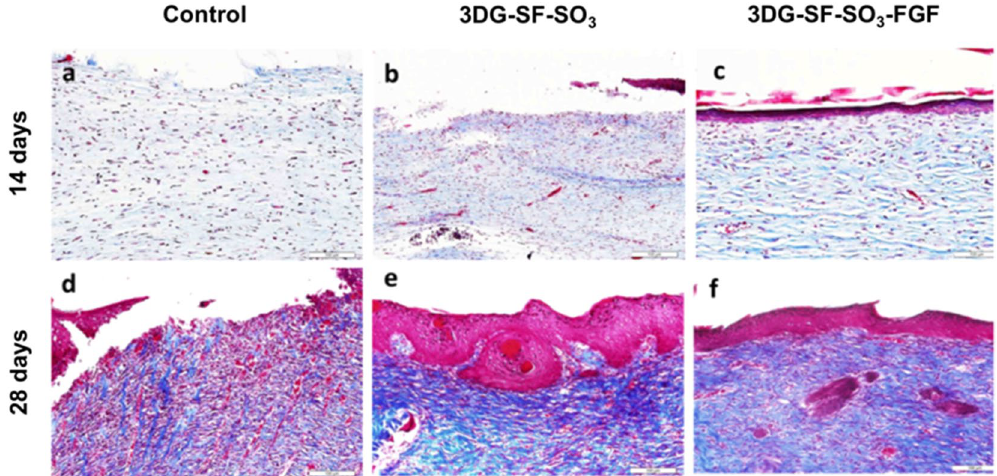
Figure 7. Masson trichrome staining shows histology of repaired wound after treatment. with petroleum gauze ( a , d ), 3DG-SF-SO 3 scaffold ( b , e ) and 3DG-SF-SO 3 -FGF scaffold ( c , f ) at 14 and 28 days post-surgery. Scale bars = 100 μ m.